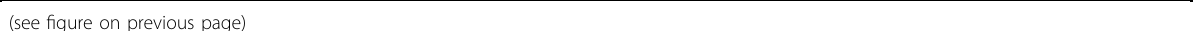
Fig. 3 Dysregulated pathways in SMCs during the development of TAAD. a Network view of the differentially regulated REACTOME pathways in SMCs at the early stage of TAAD induction. The size of the dot re fl ects the size of the gene set. The dots in red denote upregulated pathways, and the dots in blue represent downregulated pathways. The signi fi cance threshold of the GSEA test was set to an FDR q value of 0.05. b Enrichment plots (upper panel) and leading-edge gene expression heatmaps (lower panel) for representative pathways dysregulated in SMCs at the early stage of TAAD induction. NES, normalized enrichment score. The vertical lines in the enrichment plot show where the members of the gene set appear in the ranked list of genes. The average expression across cells in each group is shown in the heatmap. c The expression dynamics of representative pathways dysregulated during the induction of TAAD. Gene set-based signature scoring was performed using the method implemented in Single- Cell Signature Explorer. The expression activity of a gene set in each sample is represented by the average of the signature scores across cells in the